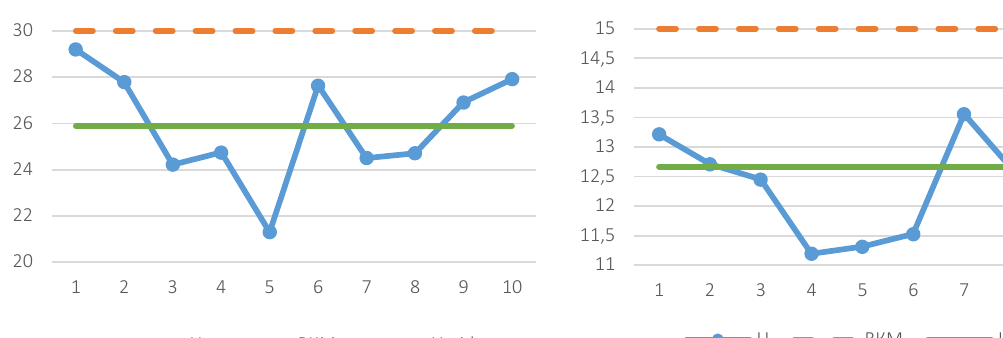
Figure 8. The Shewhart chart for the H9 (high loans, guarantees and sureties given to one insider) evolution